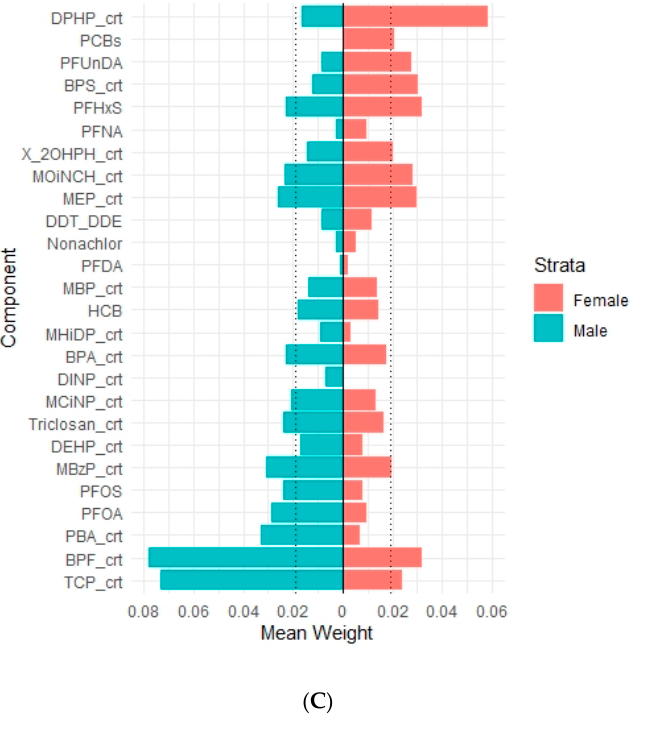
Figure 1. Estimated weight distribution in a WQS stratified regression model for 26 prenatal chemicals and 7-year IQ, using 100 repeated holdout validation datasets, for ( A ) boys; ( B ) girls; and ( C ) a divergent plot comparing the mean estimated sex-specific weights. Notes ( A , B ) Bars correspond to the right axis and indicate the percent of times a chemical exceeded the concern threshold in 100 repeated holdouts. Data points, boxplots, and diamonds correspond to the left axis. Data points indicate weights for each of the 100 holdouts. Box plots show 25th, 50th, and 75th percentiles, and whiskers show 10th and 90th percentiles of weights for the 100 holdouts. Closed diamonds show mean weights for the 100 holdouts; ( C ) The dotted lines represent the threshold guideline from the equi-weighted index (i.e., 1/(2c), where c is the number of components.